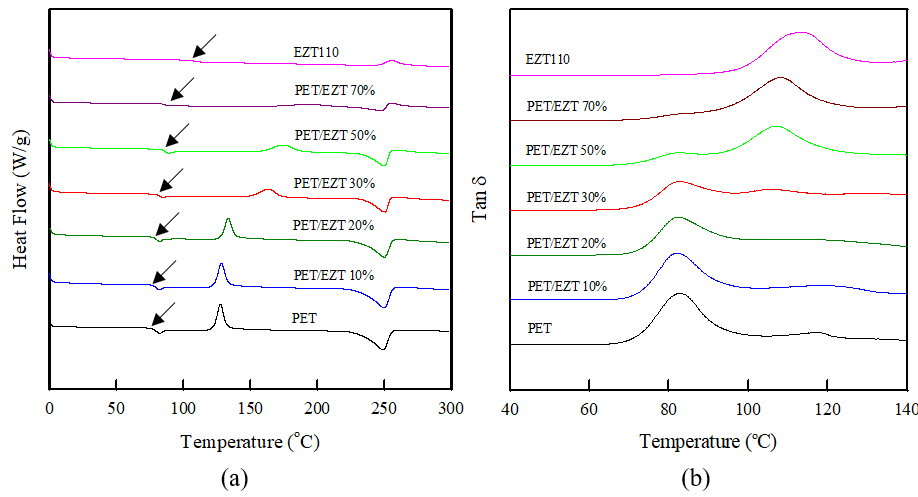
Figure 3. ( a ) DSC curves and ( b ) tan δ curves of the PET/EZT samples. Table 1. Thermal properties of the PET/EZT samples obtained from DSC and DMA Table 1. Thermal properties of the PET/EZT samples obtained from DSC and DMA analysis.